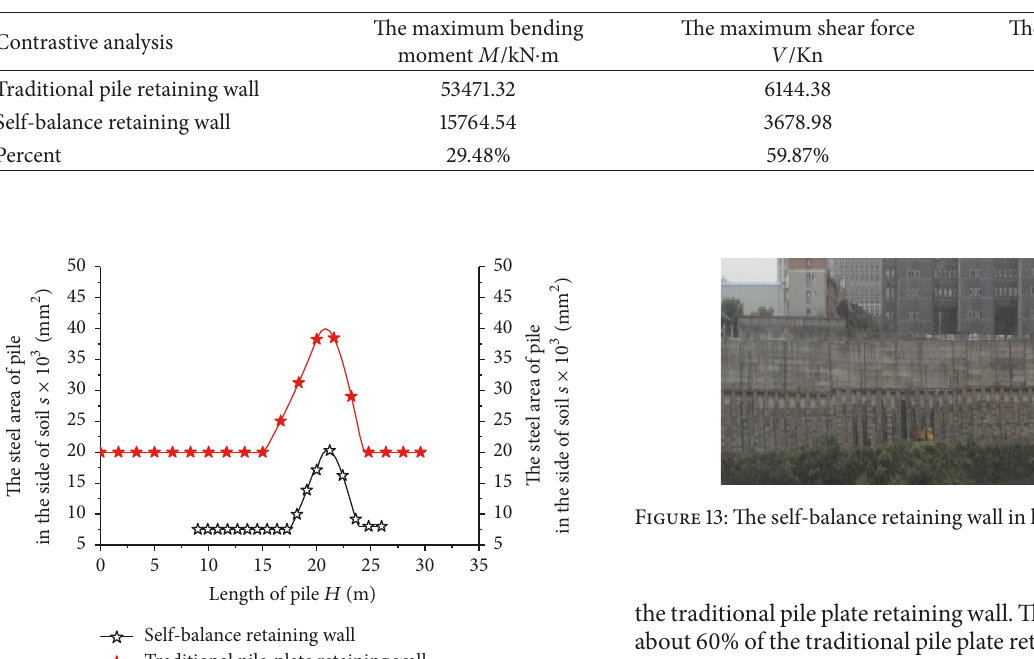
Table 2: Comparison of the peak internal force.